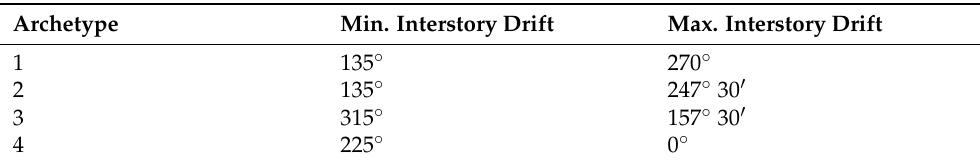
Table 6. Summary of the angles of incidence that produce the maximum and minimum interstory drifts on the